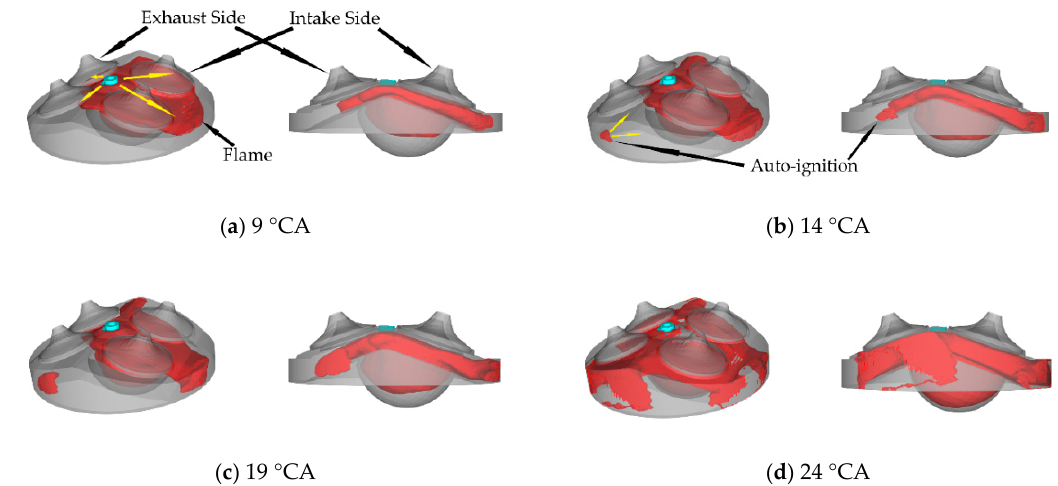
Appl. Sci. 2019 , 9 , x FOR PEER REVIEW Figure 12. Flame propagation of knock combustion (intake port on the right). Figure 12. Flame propagation of knock combustion (intake port on the right). Figure 12. Flame propagation of knock combustion (intake port on the right).